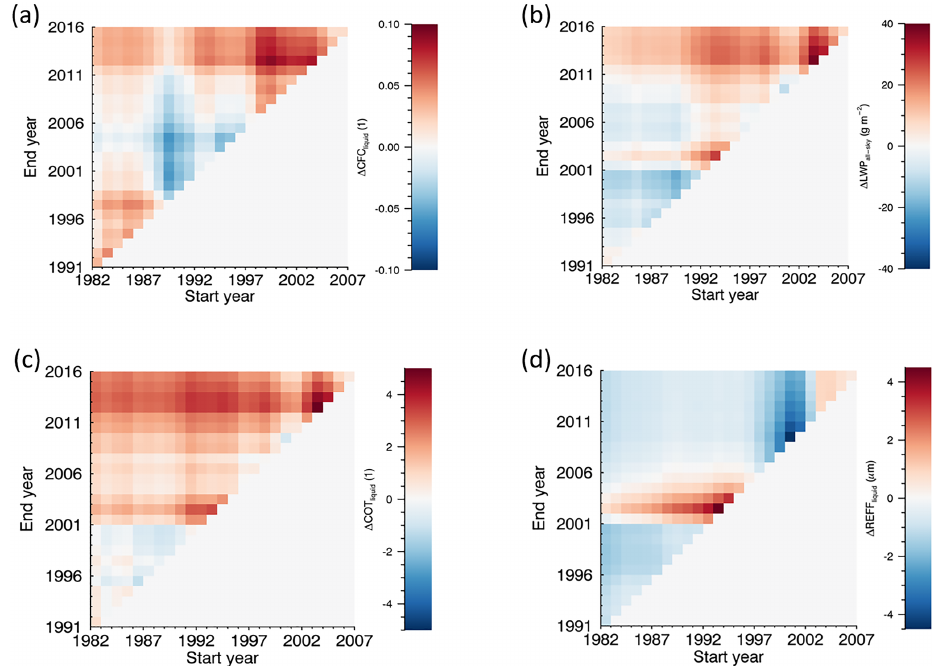
Figure 9. Changes in liquid cloud properties over southern China, based on 34 years of CLARA-A2 data (1982–2015) and estimated for all possible combinations of start and end years, with a minimum time range of 10 years. The four plots show corresponding changes in (a) all-sky LWP, (b) liquid CFC, (c) liquid COT and (d) liquid